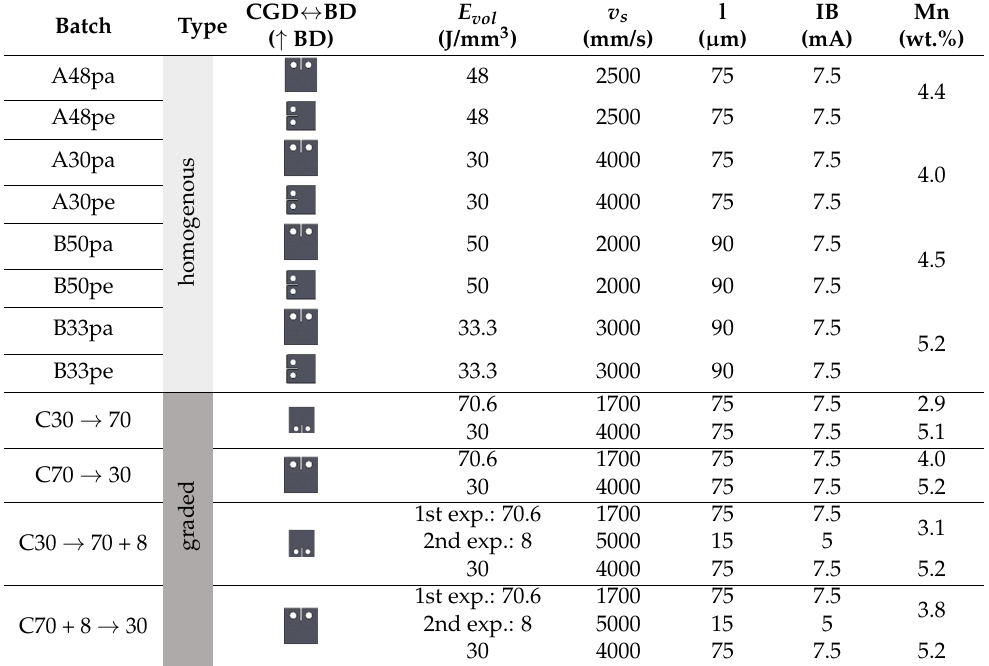
Figure 1. Arrangement of the blocks during PBF-EB processing of batches A ( a ), B ( b ), and C ( c ) as well as a schematic detailing extraction of a miniature CT-specimen from a block (( d ), CGD ⊥ BD) and geometry of miniature CT-specimens (( e ), dimensions in mm). Table 2. Overview of the homogenous and graded material states, the CGD of the associated CT- specimens in relation to the BD (vertical, bottom up), the PBF-EB parameters used and the resulting Mn content according to spark emission spectroscopy measurements. Acceleration voltage U A and layer thickness t were kept constant at 60 kV and 50 µ m, respectively. In the upper half of the blocks of material states C30 → 70 + 8 and C70 + 8 → 30, each layer was exposed to energy input by the electron beam twice. v s : scan speed, l : hatch distance, I B : beam current, E vol : energy input per volume unit, exp.: